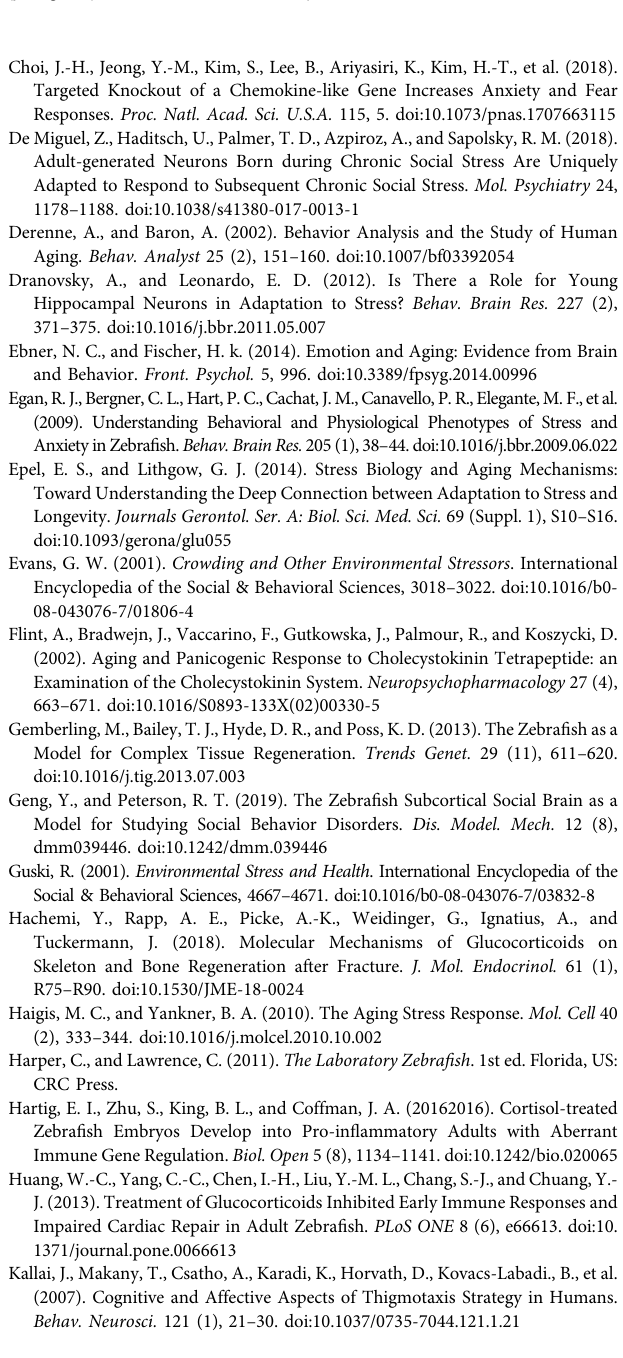
Supplementary Table S1 | Procedure of the unpredictable chronic stress (UCS) protocol in zebra fi